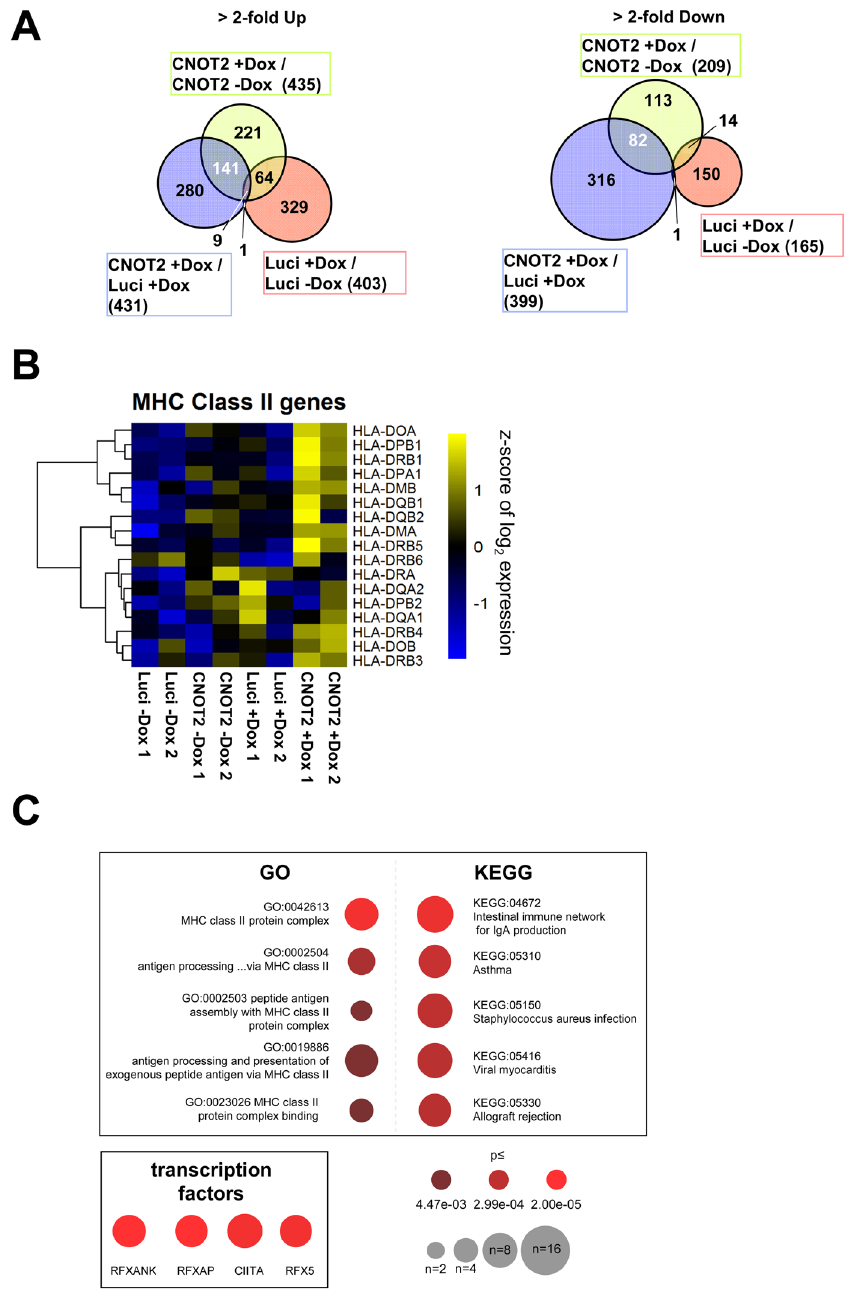
Figure 4. Analysis of CNOT2-dependent transcription programs. ( A ) The 293 T cells with a stably integrated pIND CNOT2 or a pIND Luci control plasmid remained untreated or were treated for 4 days with Dox, followed by analysis of gene expression using Agilent microarrays. The microarray data from the new experiment and from the previous experiment were analysed together using the Limma package of Bioconductor with the R software. Venn diagrams show the overlap of regulated genes more than 2-fold in each of the comparisons indicated. Bona fide CNOT2 target genes were identified by simultaneous comparison between pIND CNOT2 + Dox versus pIND CNOT2 -Dox and also between pIND CNOT2 + Dox versus pIND Luci + Dox. This procedure eliminates gene regulatory events attributable to Dox treatment (shown in red) or to the differences in the cell line background. Only genes with significant hybridization signals for all three conditions were considered. ( B ) The heat map visualizes a cluster analysis showing the expression level changes of the MHC class II genes in the different samples hybridized to the microarrays. ( C ) Upper: The 141 upregulated and 82 downregulated CNOT2 target genes identified in ( A ) were analyzed for overrepresentation in the KEGG and GO pathway databases using a Fisher’s exact test, the top 5 pathways are displayed. Lower: Candidate transcription factors mediating the transcriptional changes were revealed by the TRRUST database of transcription factors. The number of regulated genes within the pathways and their statistical relevance are displayed as in Fig.